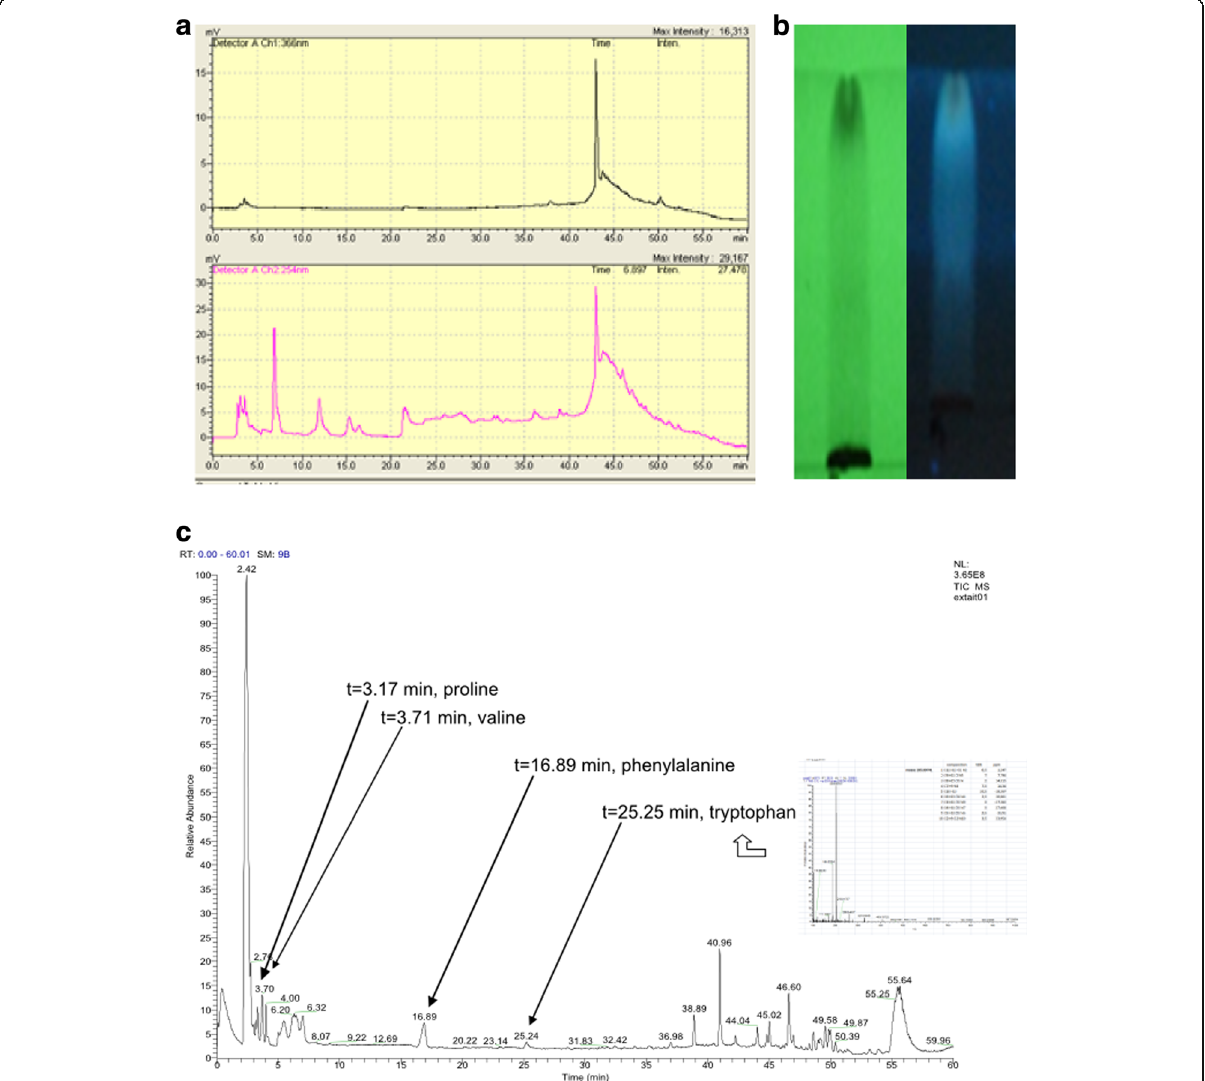
Fig. 3 NVH HPLC, TLC and HR-LC-MS profiles. a: NVH HPLC profile using acetonitrile at different percentages and time ranges (0, 0, 5, 5, 10, 20, 100% respectively during 1 – 10, 10 – 15, 15 – 20, 20 – 25, 25 – 35, 35 – 50, 50 – 60 min). The upper part represents NVH HPLC profile at 366 nm and the lower part, NVH HPLC profile at 254 nm. b : NVH TLC fingerprint at 254 nm (left) and 366 nm (right) using water: methanol: acetic acid (12.5,12.5:1). c : NVH HR-LC-MS profile with the four identified amino